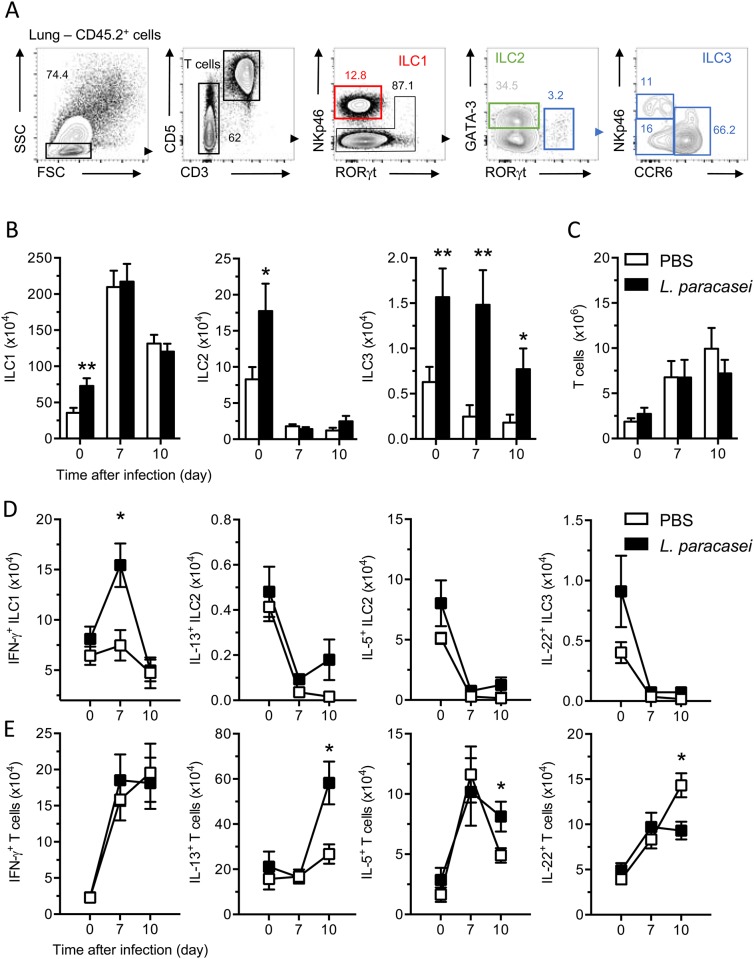
Effects of consumption of L. paracasei on ILCs and T effector cells.(A). gating strategy for FACS analysis of mouse lung. ILC1 were gated on CD45+CD3-CD5-RORγt-NKp46+, ILC2 were gated on CD45+CD3-CD5-RORγt-GATA-3hi cells and ILC3 were gated on CD45+CD3-CD5-RORγt+ cells. The analysis of ILC3 subsets were supported by the expression of NKp46 and CCR6. Numbers adjacent to boxed areas indicate relative percentage of gated populations. Representative results from 4 independent experiments. (B-C) Representative histograms show the absolute numbers of ILC subsets (B) T cells (C) in lung. (D) Lung cells were stimulated for 4h with IL-12, IL-18, IL-33, IL-23 and IL-1β and IFN-γ, IL-5, IL-13 and IL-22 expression in ILCs and T cells was assessed by intracellular cytokine staining and flow cytometry. Graph represents the absolute numbers of cells. Representative results from 4 independent experiments (n = 9/group). *, P<0.05.